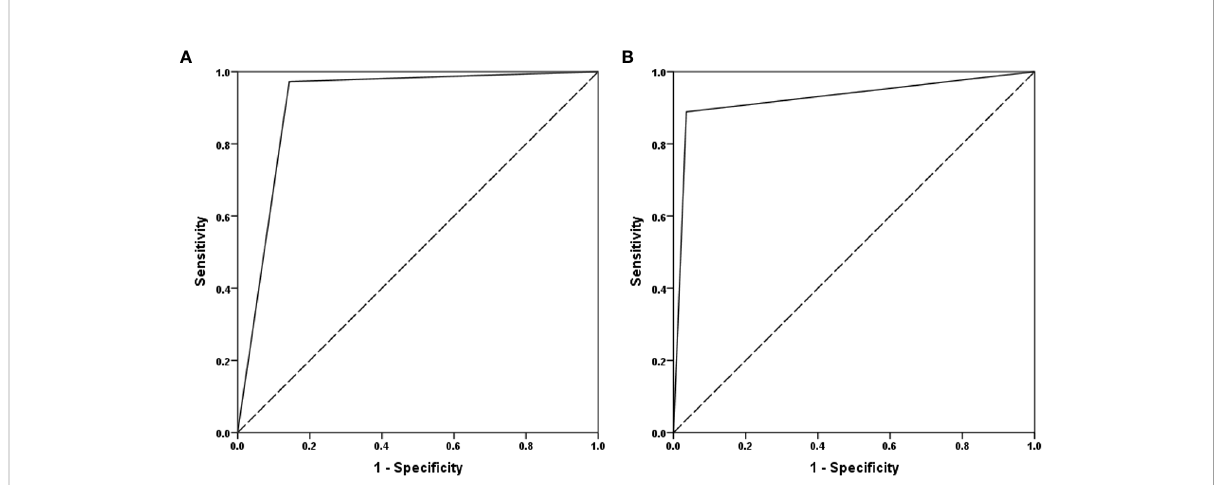
FIGURE 2 The ROC curve of SROS and MRI-OA. (A) MRI-OA; (B) SROS (SROS, self-report olfactory scale; MRI-OA, MRI of olfactory